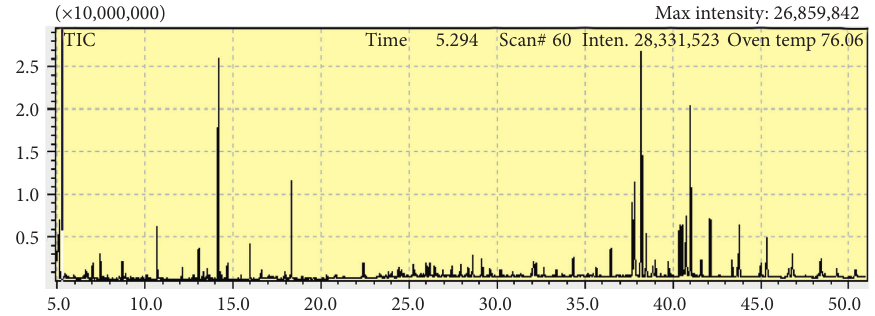
Figure 1: GC-MS analysis of Juglans regia